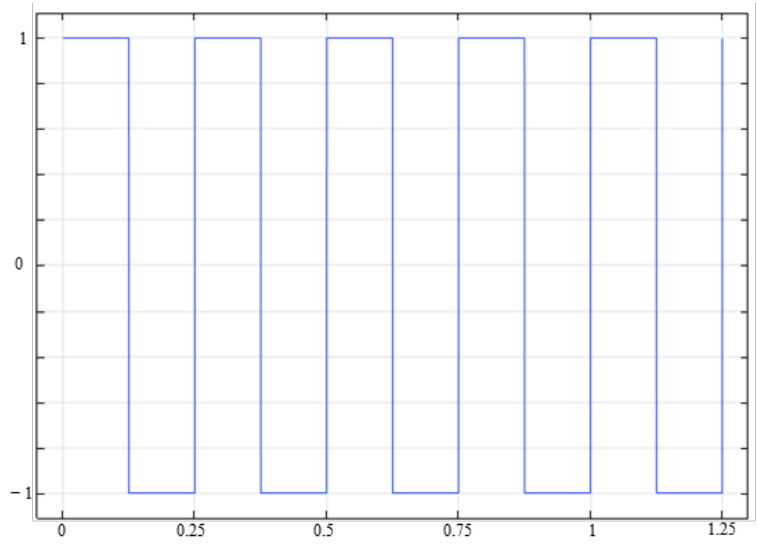
Figure 6. The input voltage waveform of simulation model. Table 3. Material parameters of the adhesive Table 2. Field model parameters.